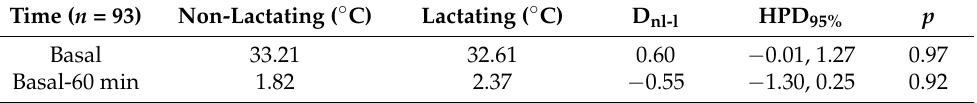
Table 3. Effect of lactation on basal temperature and temperature range between basal and 60 min. Time ( n = 93) Non-Lactating ( ◦ C) Lactating ( ◦ C) D nl-l HPD 95% p Basal 33.21 32.61 0.60 − 0.01, 1.27 0.97 Basal-60 min 1.82 2.37 − 0.55 − 1.30, 0.25 0.92